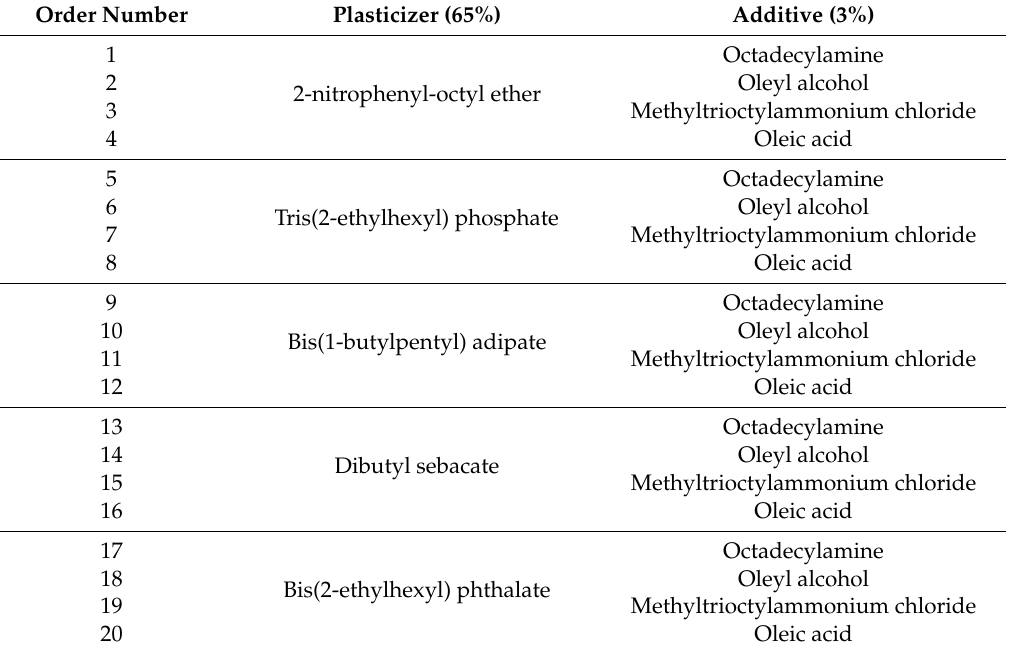
Table 2. Numeration assigned to each polymeric membrane position in the sensor array.